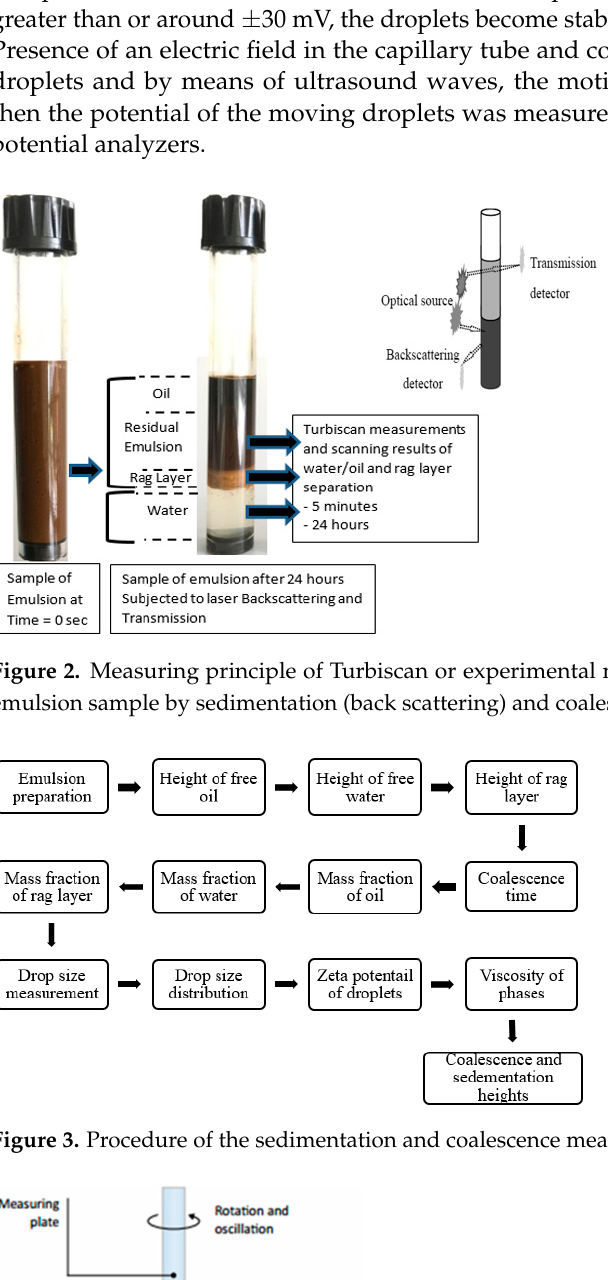
Figure 3. Procedure of the sedimentation and coalescence measurements.